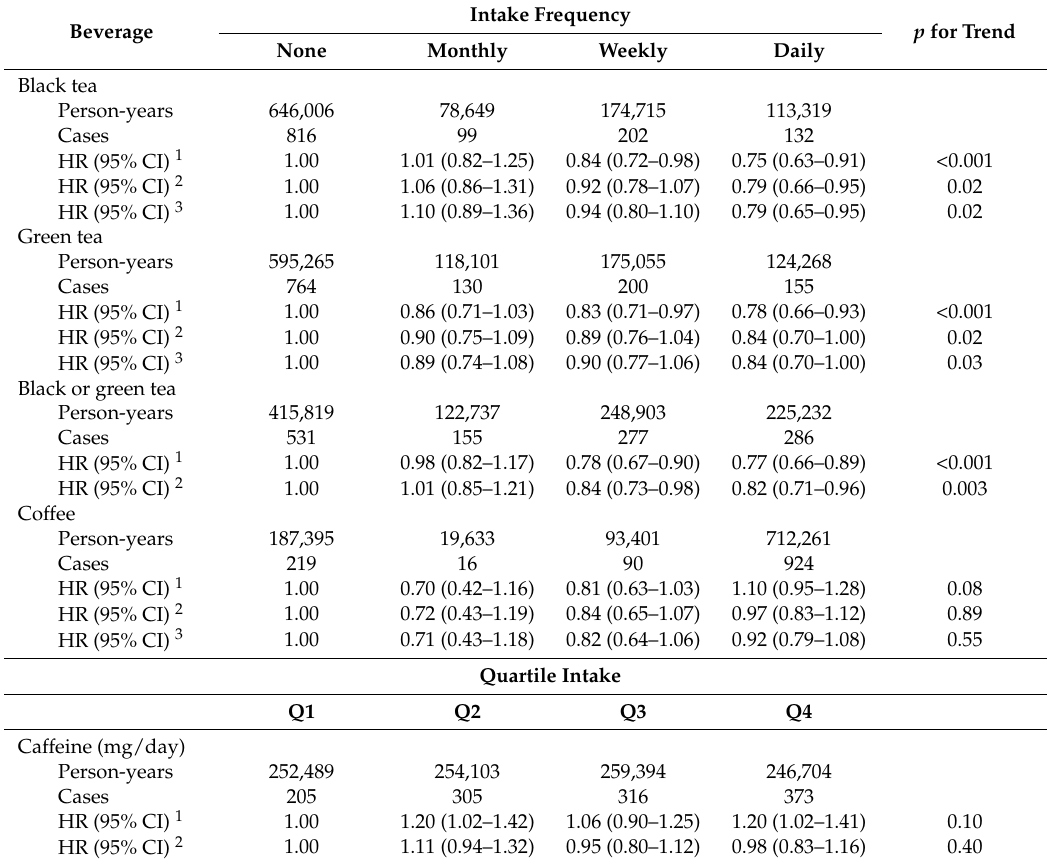
Table 2. Intake of tea, coffee, and caffeine in relation to risk of